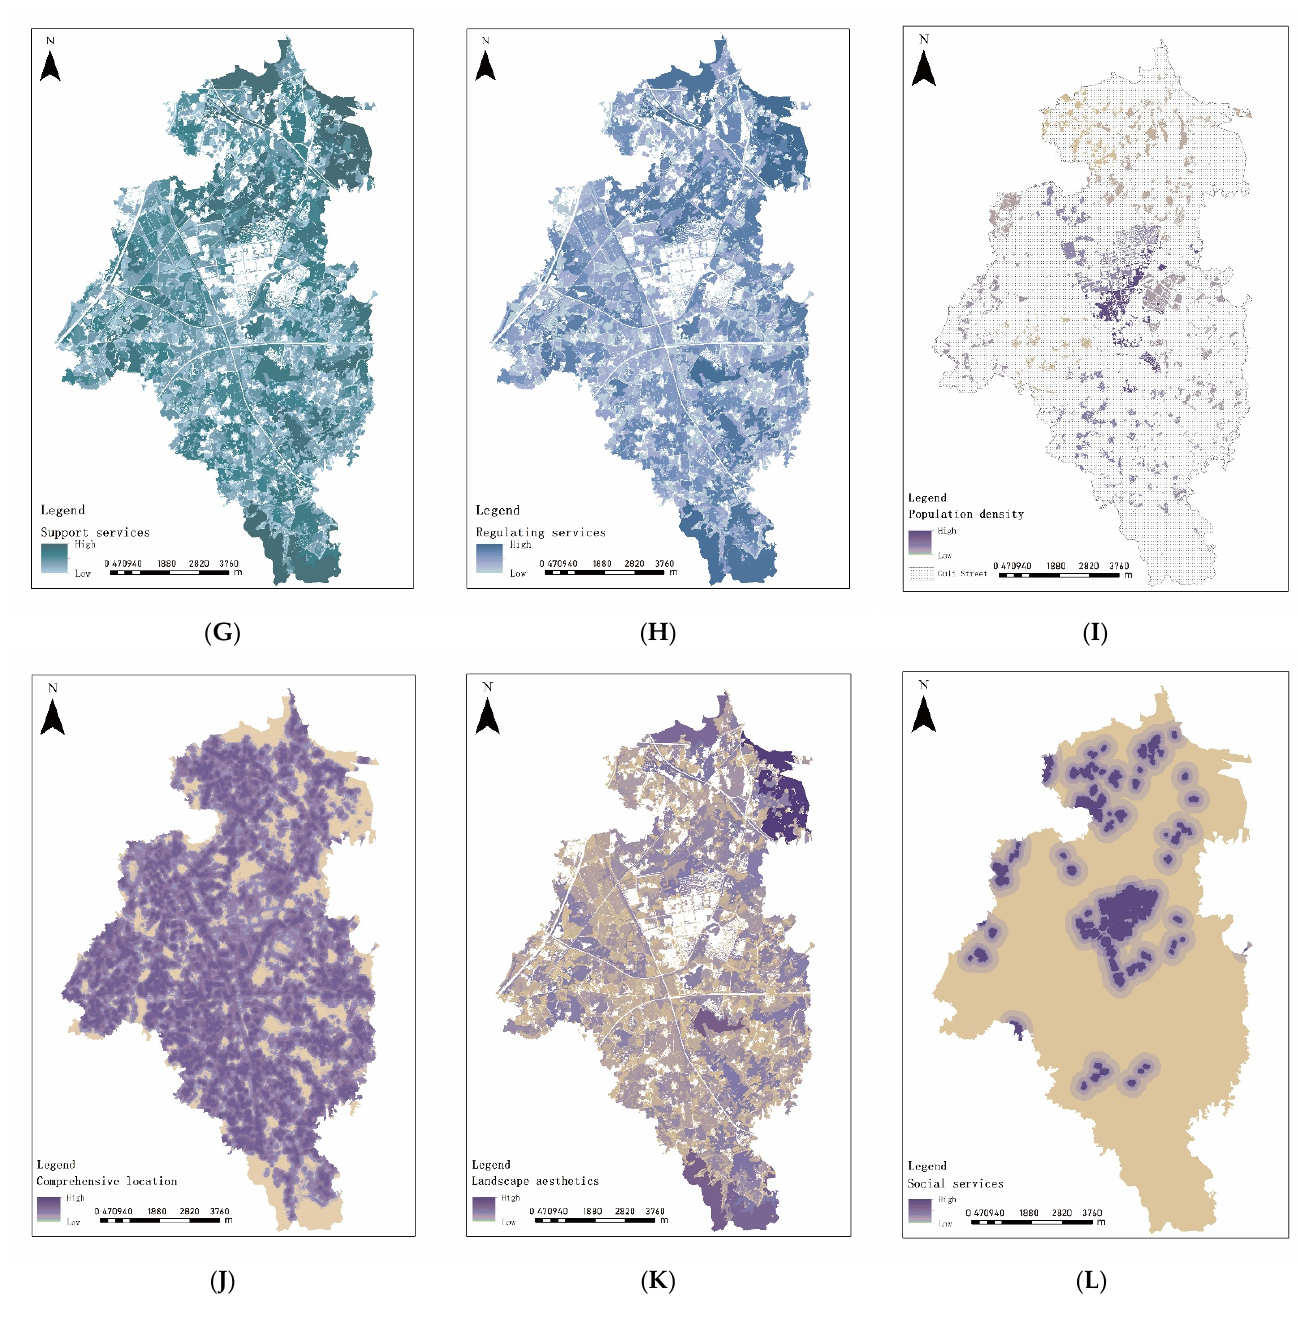
Figure 4. Subfunction distribution patterns of PLE. ( A ) Cultivated land production (CLP); ( B ) Food production (FP); ( C ) Raw material production (RMP); ( D ) Agricultural land quality (ALQ); ( E ) Habitat quality (HQ); ( F ) Landscape maintenance (LM); ( G ) Support services (SS); ( H ) Regulating services (RS); ( I ) Population density (PD); ( J ) Comprehensive location (CL); ( K ) Landscape aesthetics (LA); ( L ) Social public services